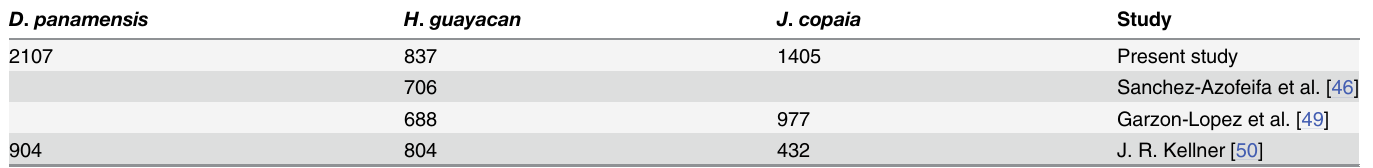
Table 2. The number of crown objects detected in the present study compared to previous